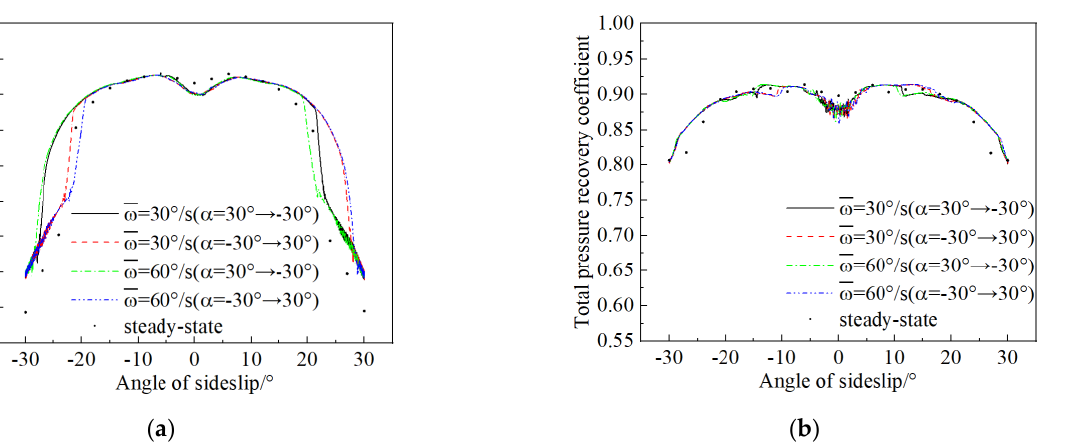
Figure 15. Total pressure recovery coefficient versus angle of sideslip. ( a ) Conventional submerged inlet ,(b) Distributed submerged inlet